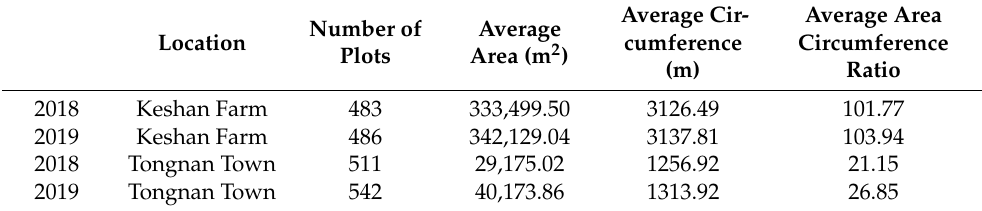
Table 2. Plot characteristics of Keshan farm and Tongnan